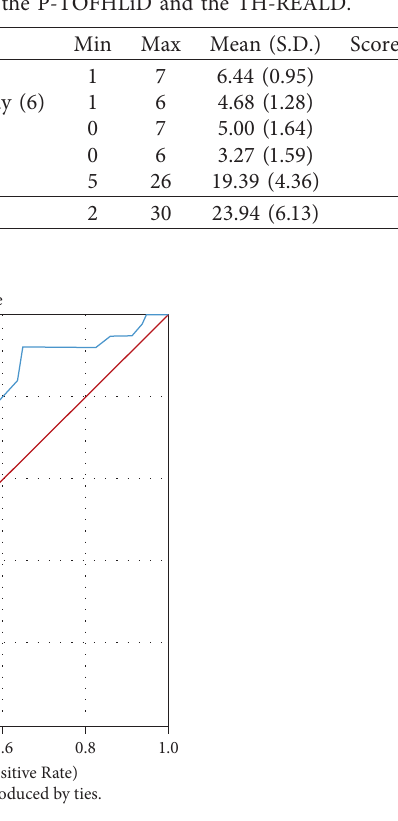
Table 2: Characteristics of study participants and comparing P-TOFHLiD scores among different dichotomous characteristics. Variables Gender School Primary caregiver Having at least one active tooth decay δ Having at least one tooth sealant or filling δ Having good oral health behaviour δ